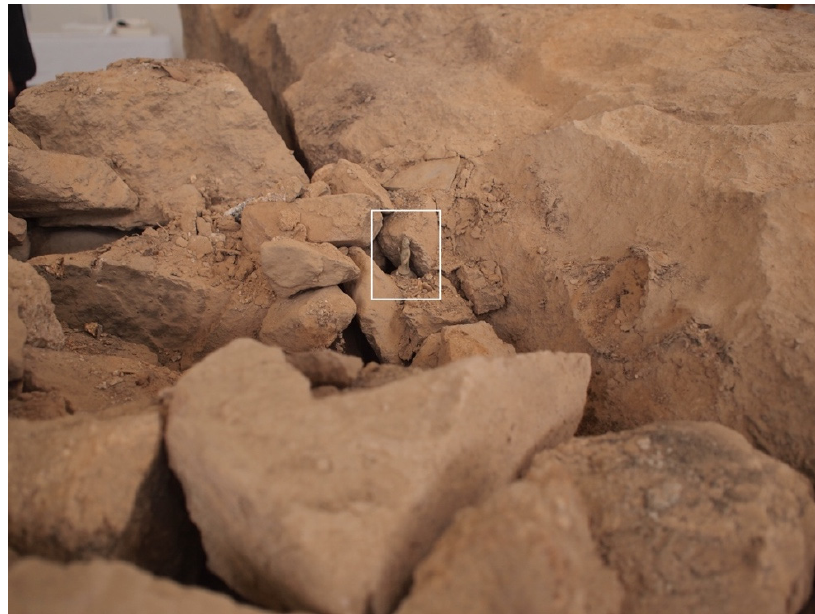
Figure 3. Gilt-bronze standing Buddha, Unified Silla, eighth century, H.4.8 cm . Three story